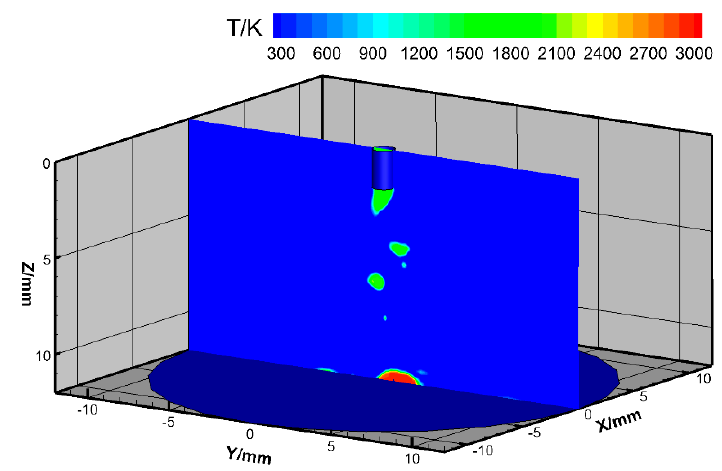
Figure 4. Droplet temperature field for high-current GMAW.